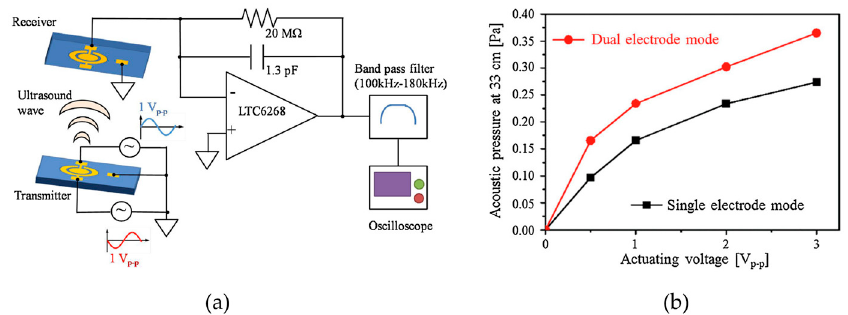
Figure 11. ( a ) A pMUT rangefinder using a dual electrode transmitter driven by anti-phase electric